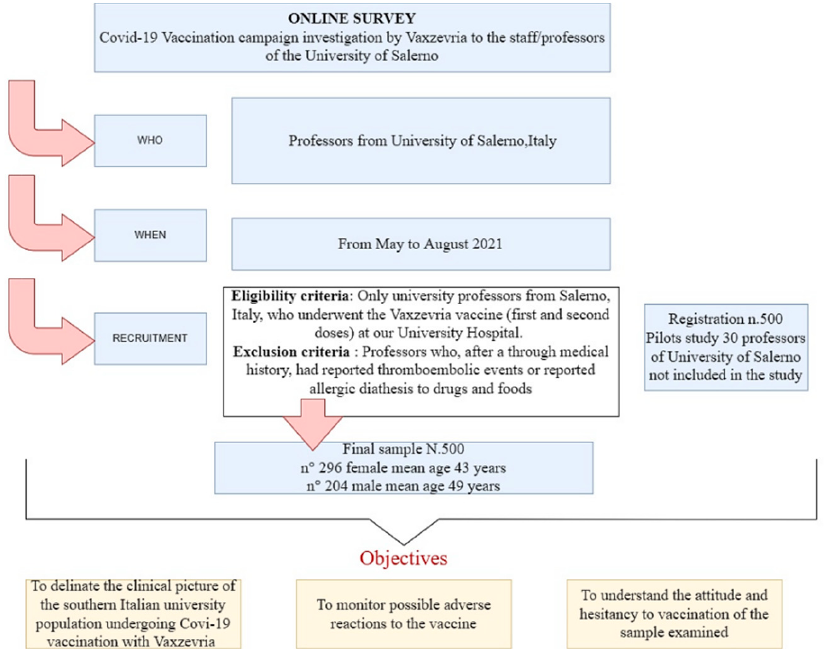
Figure 1. Survey design, including data collection, participant recruitment, and objectives. Note: For more information look at the introduction, study design and results.